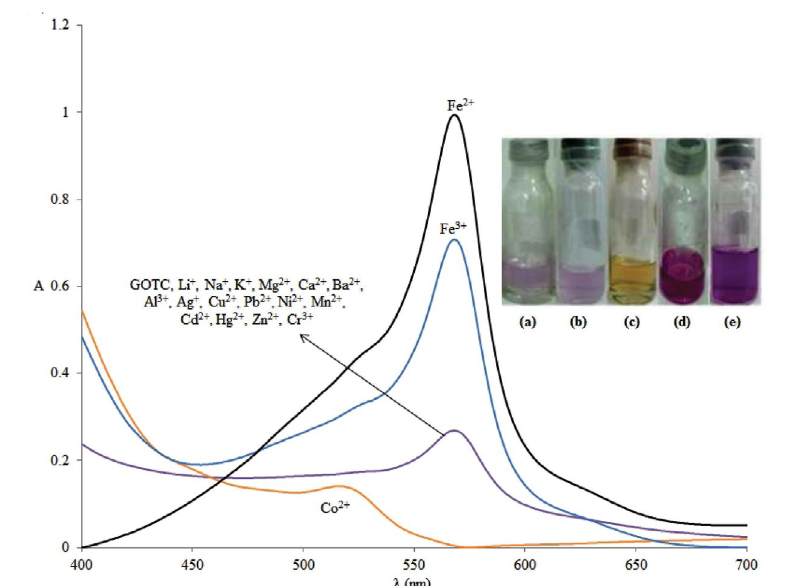
Fig. 3. The color changes of GOTC upon addition of various metal ions: (a) free GOTC (0.2 mg ml -1 ), (b) after addition of relevant metal ions (Li + , Na + , K + , Mg 2+ , Ca 2+ , Ba 2+ , Al 3+ , Ag + , Cu 2+ , Pb 2+ , Ni 2+ , Mn 2+ , Cd 2+ , Hg 2+ , Zn 2+ and Cr 3+ ), (c) Co2+, (d) Fe 3+ and (e) Fe 2+